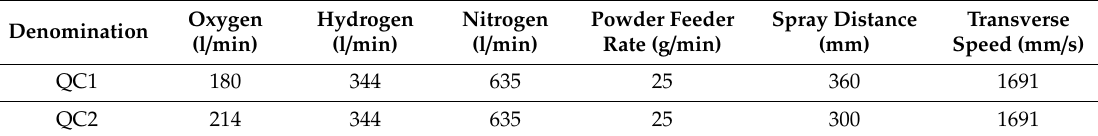
Figure 3. Scheme of the previous processes to HVOF deposition. Table 3. HVOF Spray